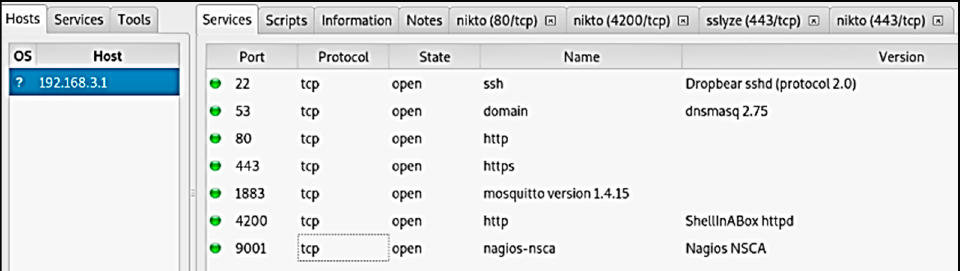
Figure 4. Open ports and services of Onion ‐ Omega2.